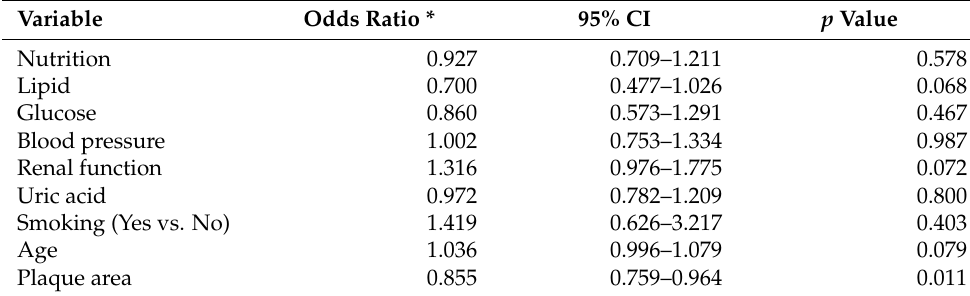
Table 8. Estimates of odds ratio from ordinal logistic regression